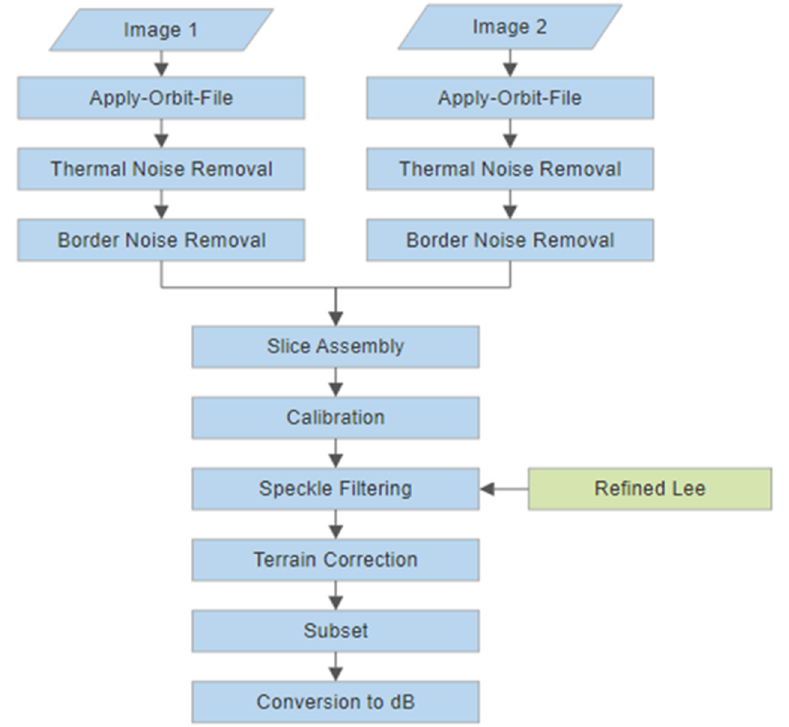
Figure 5. The workflow of pre-processing Sentinel-1 data using SNAP.